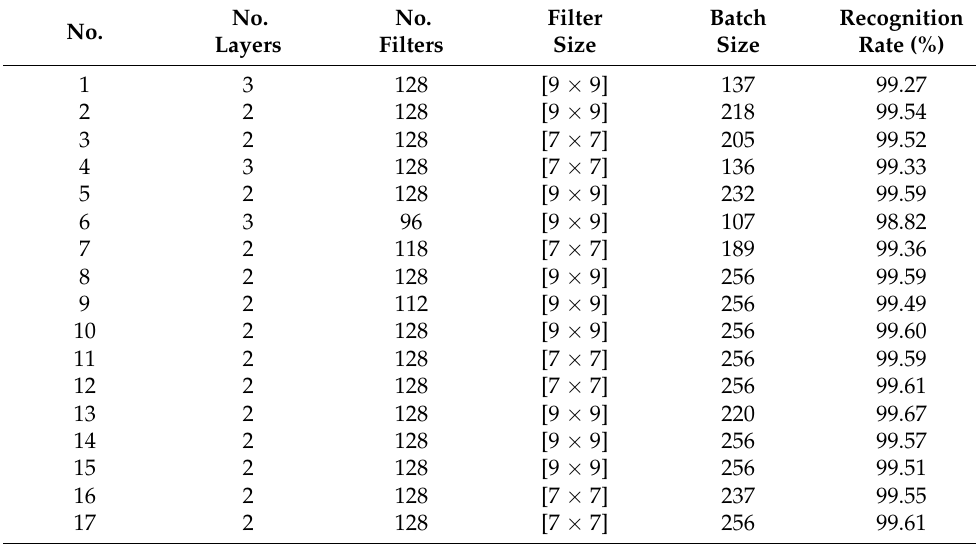
Table 10. Results achieved by the PSO-CNN-I in ASL MNIST